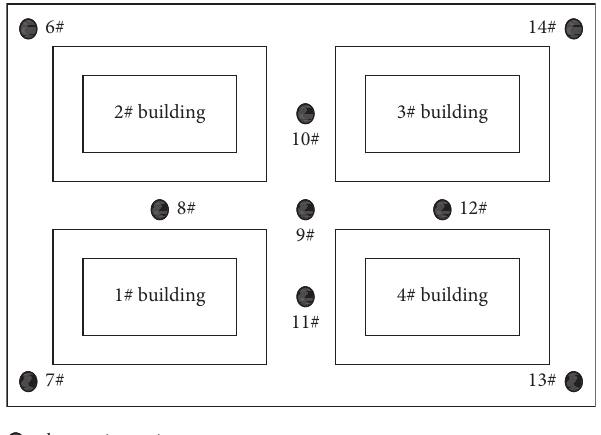
Figure 33: Observation points of buildings and pavements in the numerical